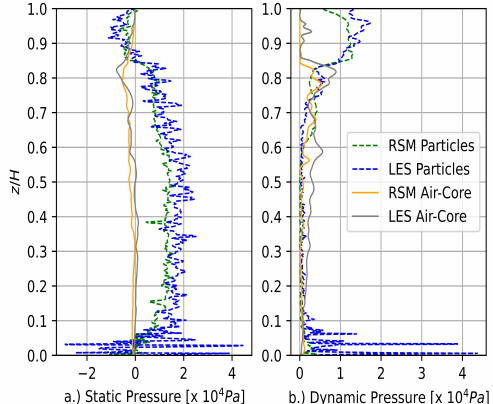
Figure 13. ( a ) Static and ( b ) dynamic pressure (Pa) as a function of the normalised z co-ordinate at flow-time 4 s for the simulations with the particles included and at flow-time 2 s for the air-core only